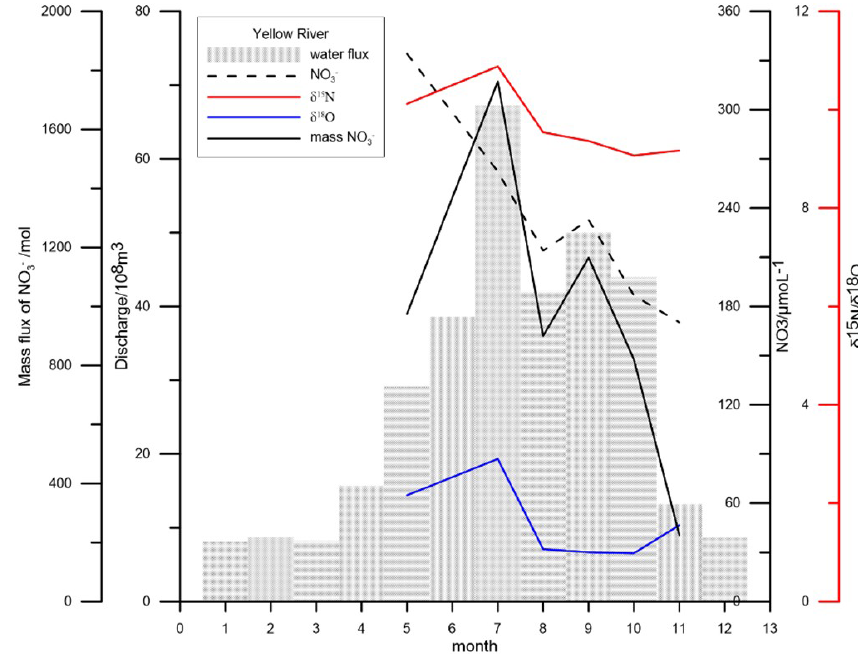
Figure 8. Monthly variation in water flux (shadowed bar), nitrate concentration (dashed line), mass flux of nitrate (solid line), and dual nitrate isotopes ( δ 15 N in upper solid red line and δ 18 O in lower solid blue line) of the YR in 2018. Water samples were collected monthly in May and July to November in Lijin, nitrate concentrations (µmolL − 1 ) and dual isotopes ( δ 15 N and δ 18 O, in per mil) were measured in home laboratory, and monthly water flux data (10 8 m 3 ) are according to the YR Sediment Bulletin 2018 (http://www.yrcc.gov.cn/nishagonggao/ 2018/index.html#p=20, last access: 28 April